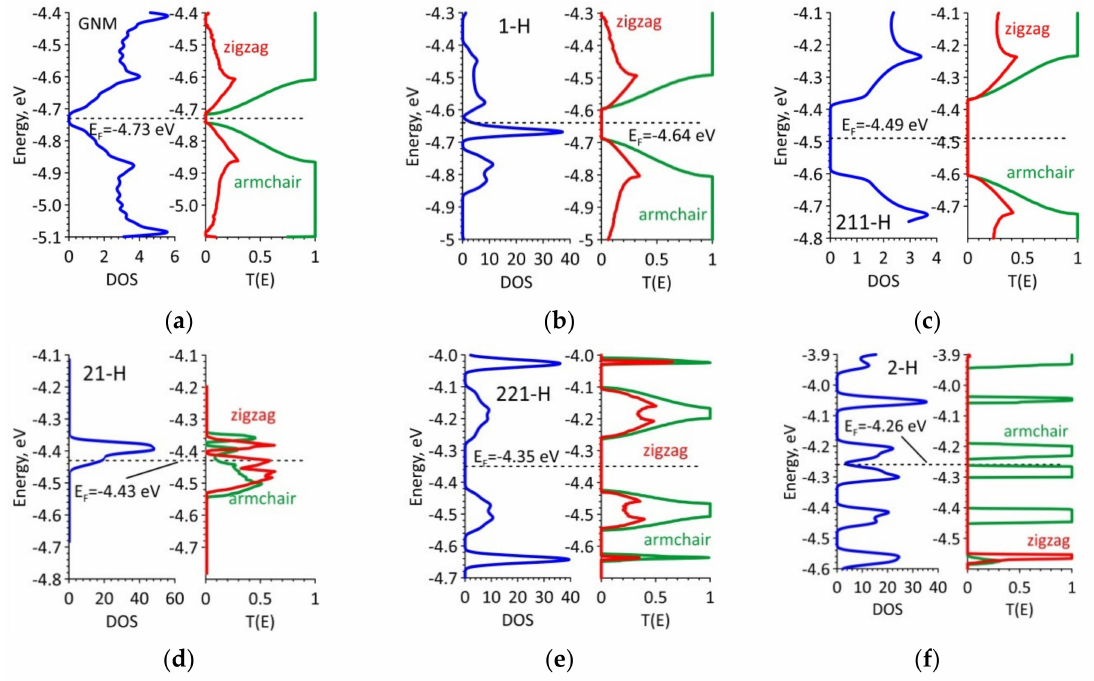
Figure 2. DOS and transmission function T(E) of GNM with various types of hydrogenation of the nanohole edges: ( a ) GNM, ( b ) GNM − 1 / 1 / 1 H, ( c ) GNM − 2 / 1 / 1 H, ( d ) GNM − 2 / 1 / 2 H, ( e ) GNM − 2 / 2 / 1 H, ( f ) GNM − 2 / 2 / 2